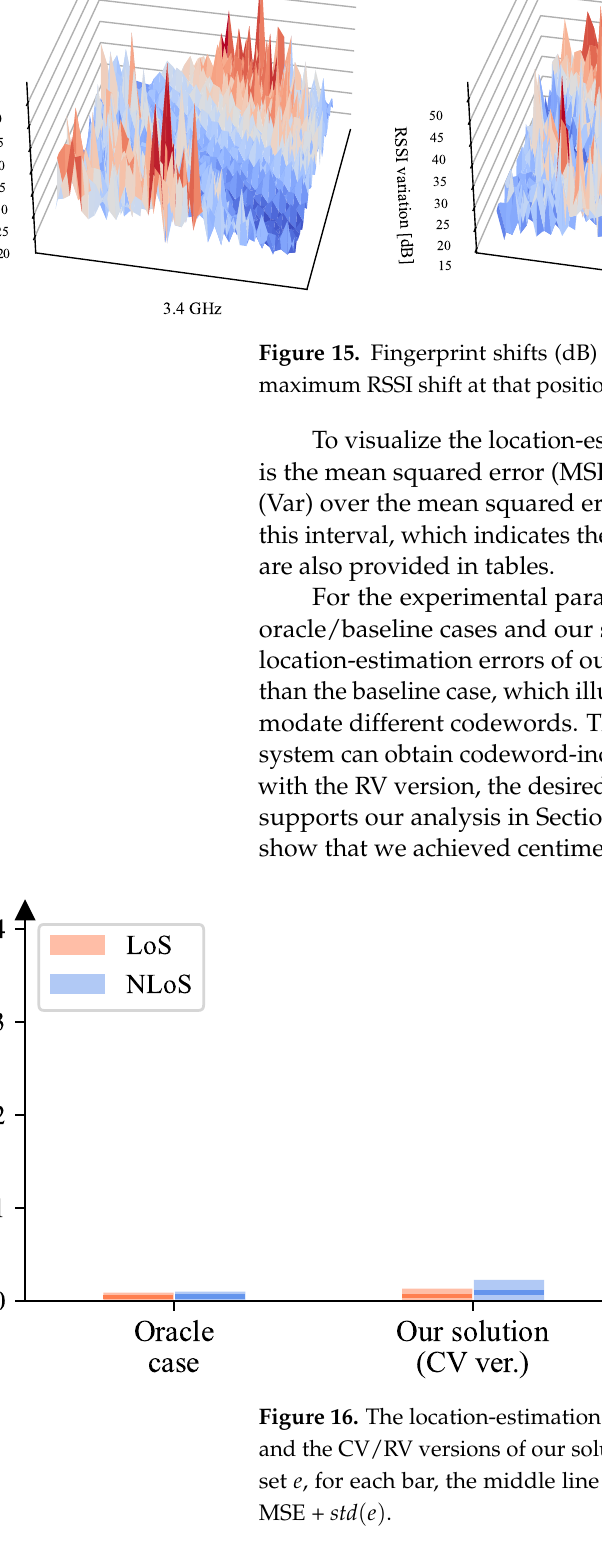
C = 144, A = 51.84, σ = 0 . { }